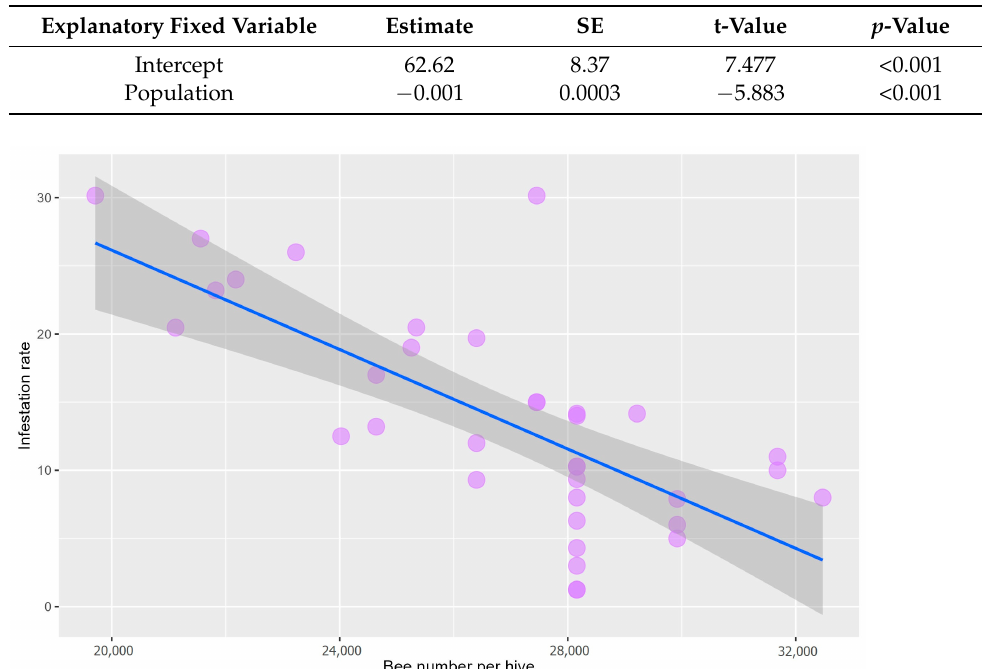
Table 2. Regression between Tropilaelaps mercedesae mite infestation rate and the population size of Apis mellifera .